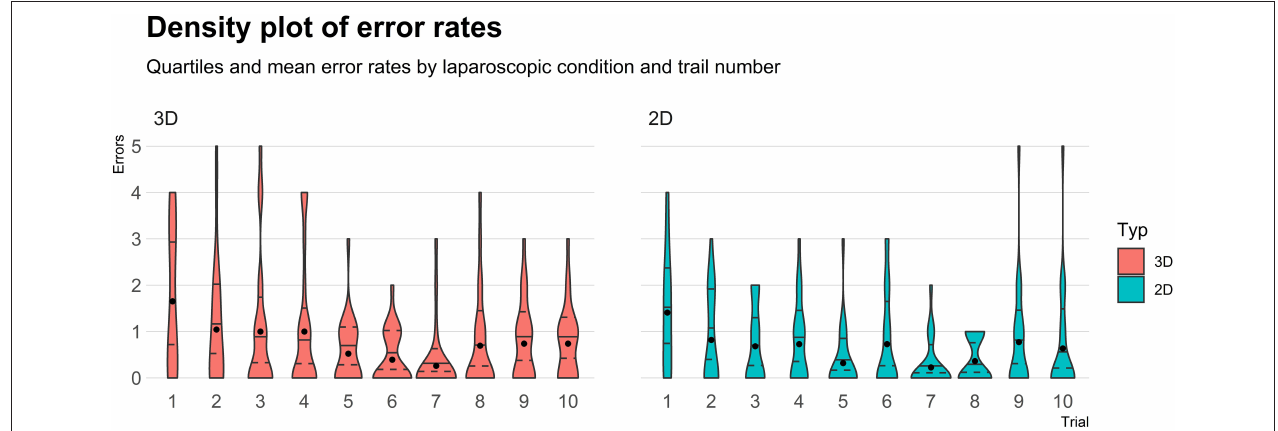
FIGURE 3 | A density plot of error rates.